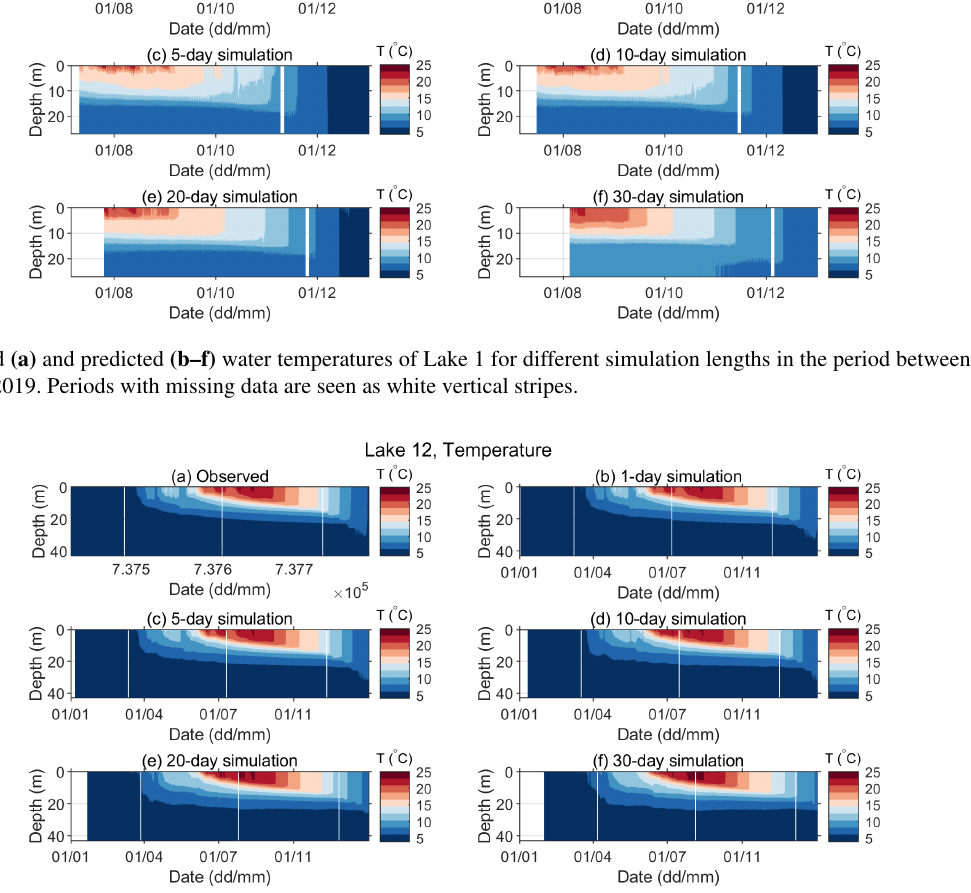
Figure 7. Observed (a) and predicted (b–f) water temperatures of Lake 12 for different simulation lengths for 2019. Periods with missing data are seen as white vertical